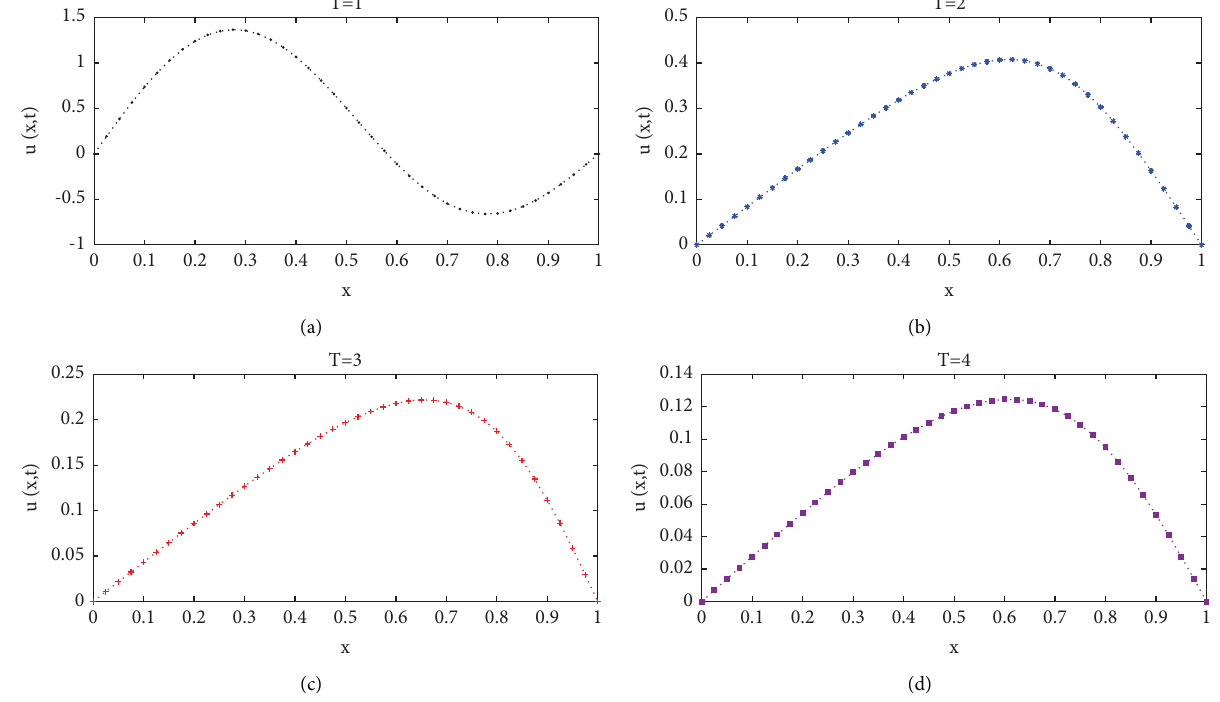
Figure 4: Physical behaviour of the test problem 3 for diferent values of time. (a) T � 1. (b) T � 2. (c) T � 3. (d) T �